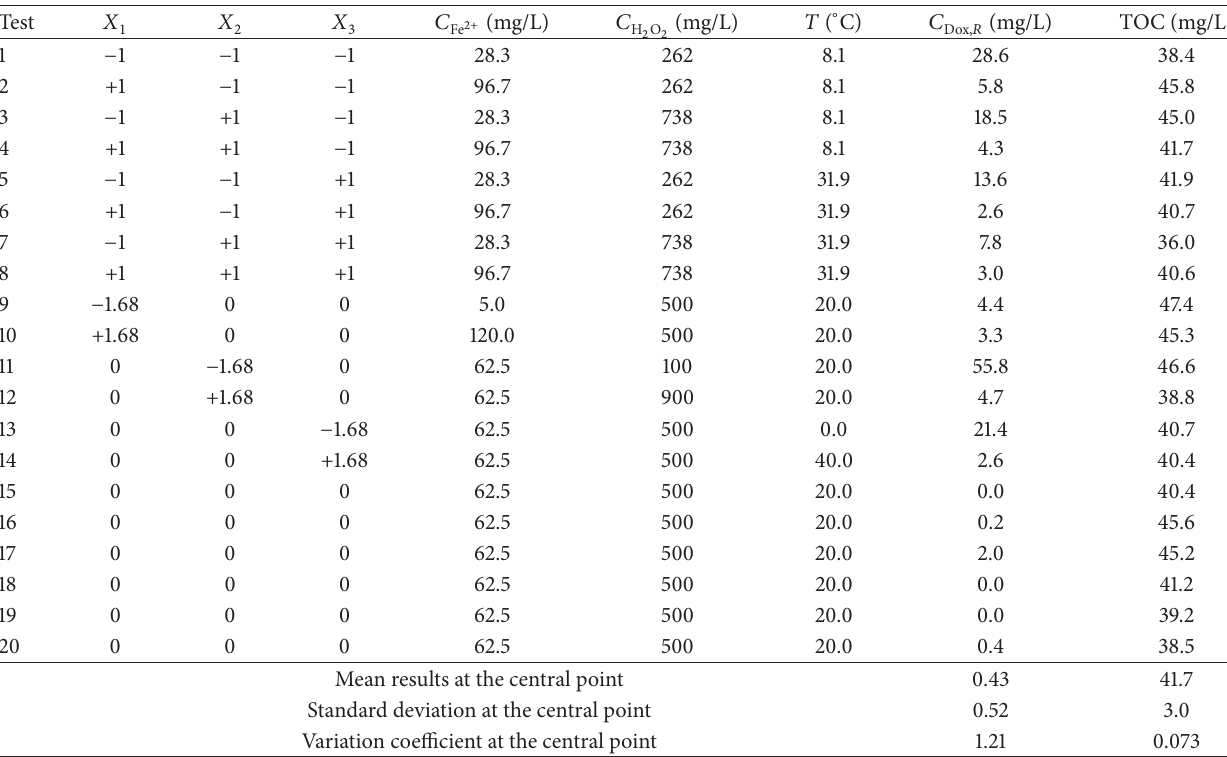
𝐶 Fe 2+ = initial concentration of ferrous ion; values of